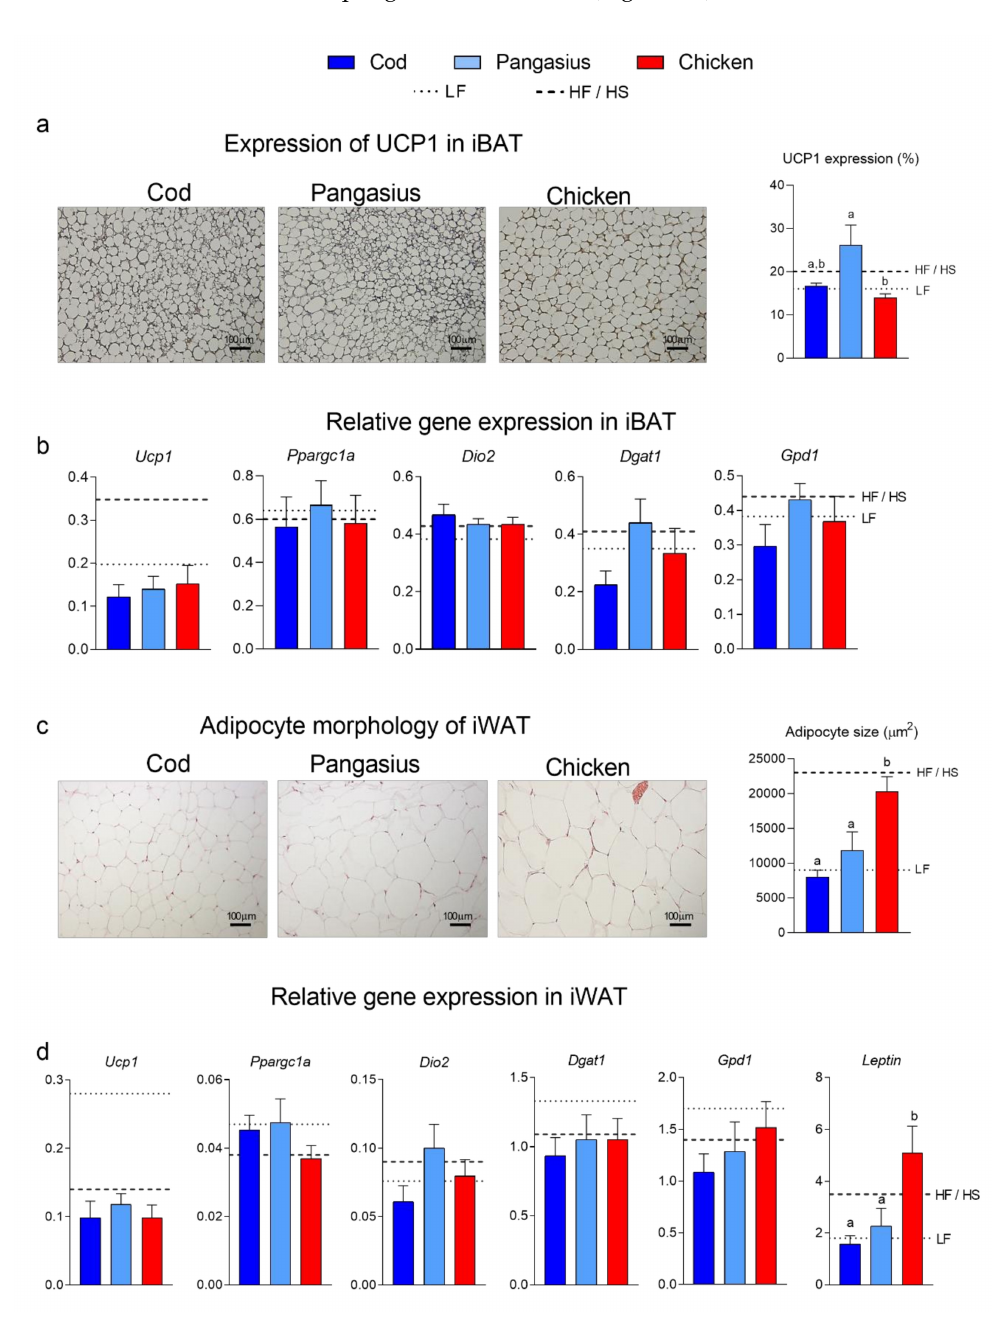
Figure 3. ( a ) Micrographs of immunohistochemically stained iBAT and quantified UCP1 expression (scalebar = 100 µ m). ( b ) Relative expressions of uncoupling protein 1 ( Ucp1 ), peroxisome proliferator activated receptor gamma co-activator 1 alpha ( Ppargc1a ), iodothyronine deiodinase 2 ( Dio2 ), diglyceride acyltransferase 1 (Dgat1 ), glyceraldehyde-3-phosphate dehydrogenase 1 ( Gpd1 ) measured by